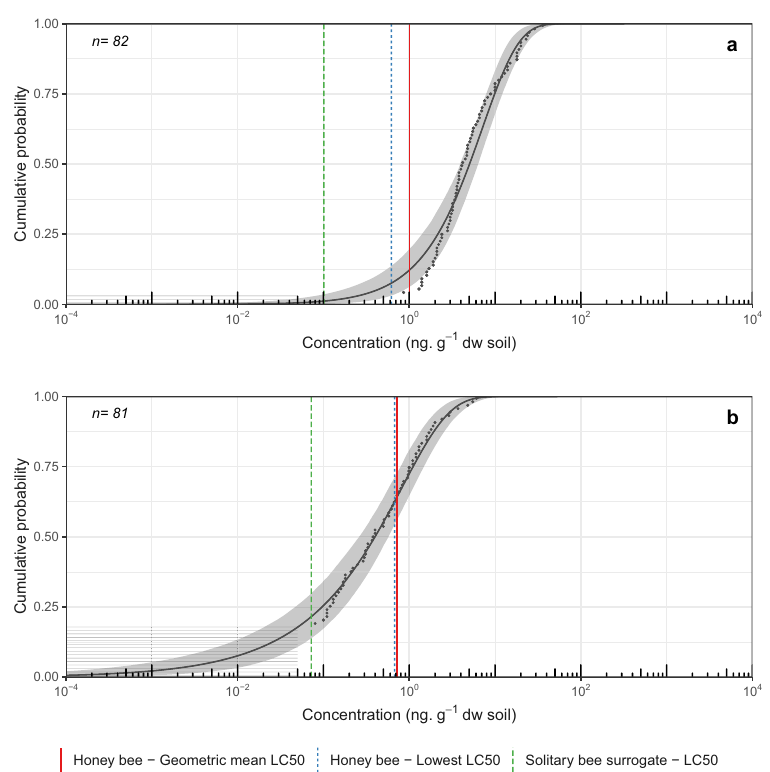
Figure 5. Environmental Exposure Distribution (EED) for chronic exposure (30 days, 33.5 g soil) to ( a ) clothianidin and ( b ) thiamethoxam in soil from field crops (corn, soybeans, wheat) based on a government dataset 13 . Soil samples were taken from 0–15 cm depth in southern Ontario, 2016. Effects benchmark concentrations are for solitary ground-nesting bees based on the hoary squash bee ( Peponapis pruinosa ) exposure model. Effect benchmarks (i.e. honey bee geometric mean LC 50 = red vertical line, honey bee lowest LC 50 = blue vertical dotted line, and the solitary bee surrogate LC 50 = green vertical dashed line) are represented on the EED. Exceedance of these endpoints is calculated by subtracting the cumulative probability from one. Grey horizontal lines represent individual soil samples below the analytical limit of detection, and black dots indicate samples for which insecticide residues could be quantified. The black line indicates the line of best fit to the data via maximum likelihood estimation (MLE) with associated 95% confidence intervals (grey